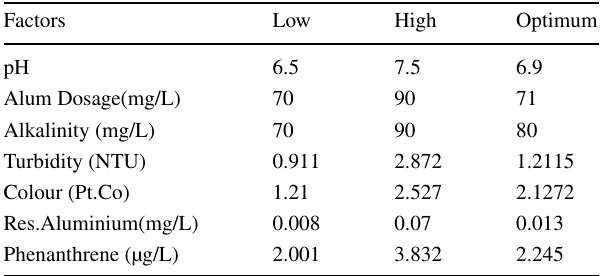
Table 7 Contaminant removal results at individual optimum desirable